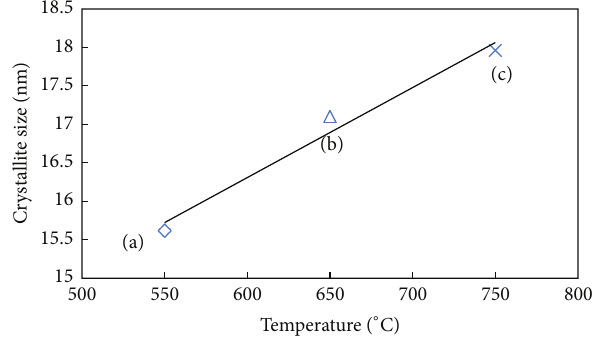
Figure 8: XRD graphical data for crystallite size versus